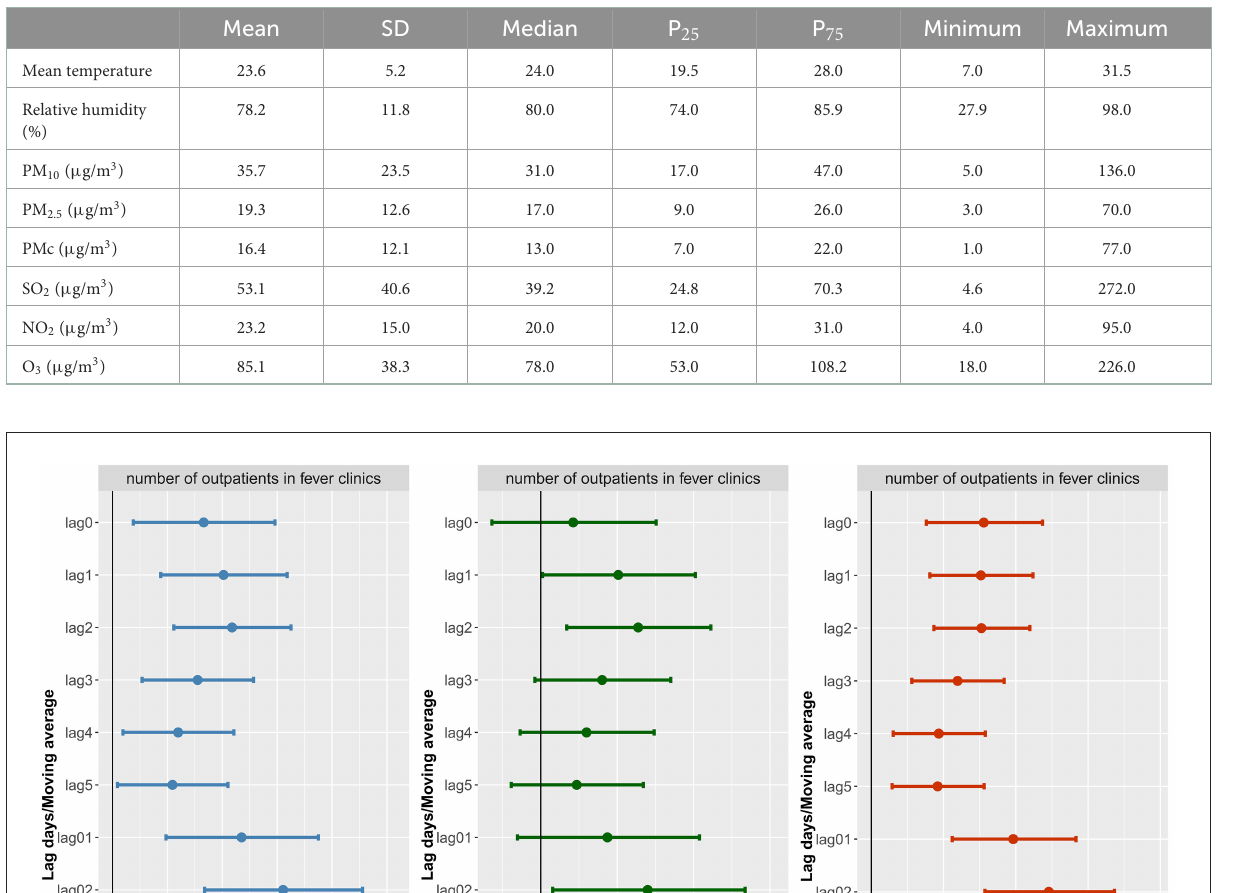
TABLE 2 Summary statistics of meteorological factors and daily air pollution in Zhuhai, 2020–2021.